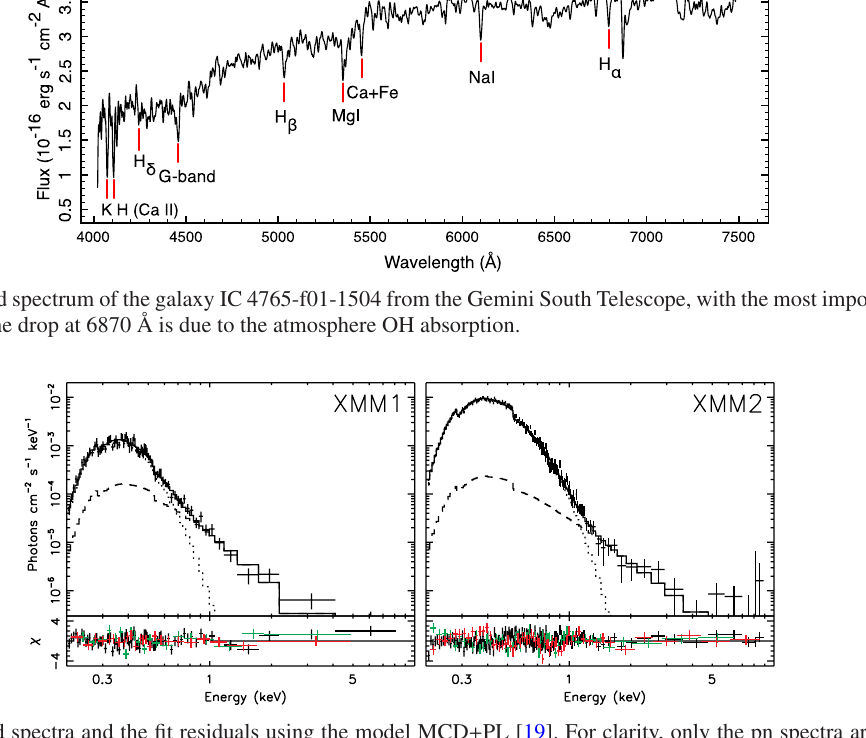
Figure 5. The unfolded spectra and the fit residuals using the model MCD + PL [19]. For clarity, only the pn spectra are shown for the unfolded spectra. The dotted, dashed, and solid lines are for the MCD and PL components and the total model, respectively. The residuals are shown for all three cameras (black / red / green for pn / MOS1 / MOS2, respectively).